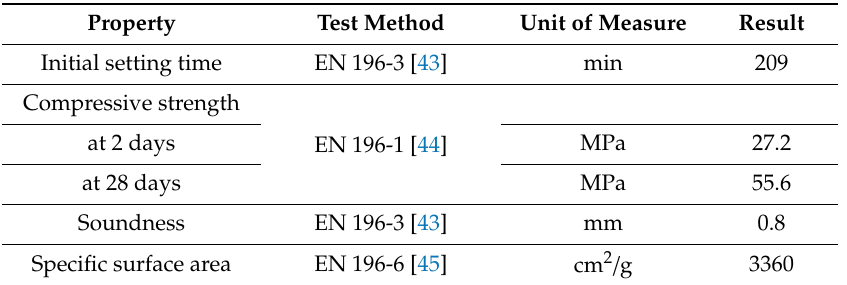
Table 6. Properties of Portland cement CEM I